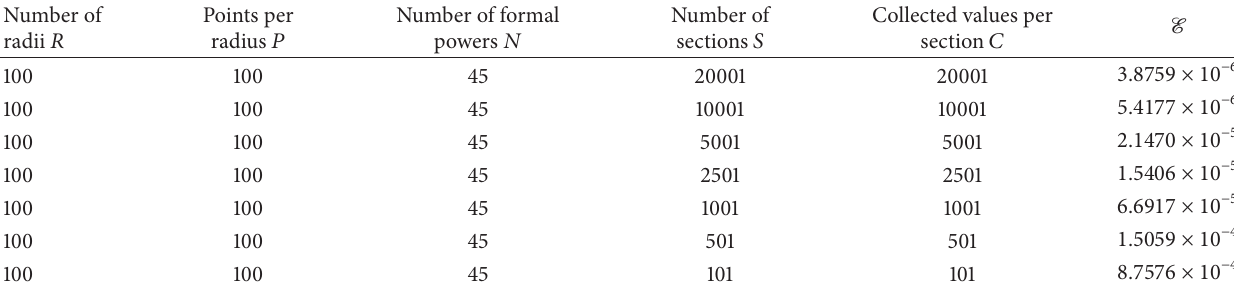
Table 7: Relation between the error E and the number of sections 𝑆 and samples per section 𝐶 , when 𝜎 = 𝑒 𝑥𝑦 . Number of radii 𝑅